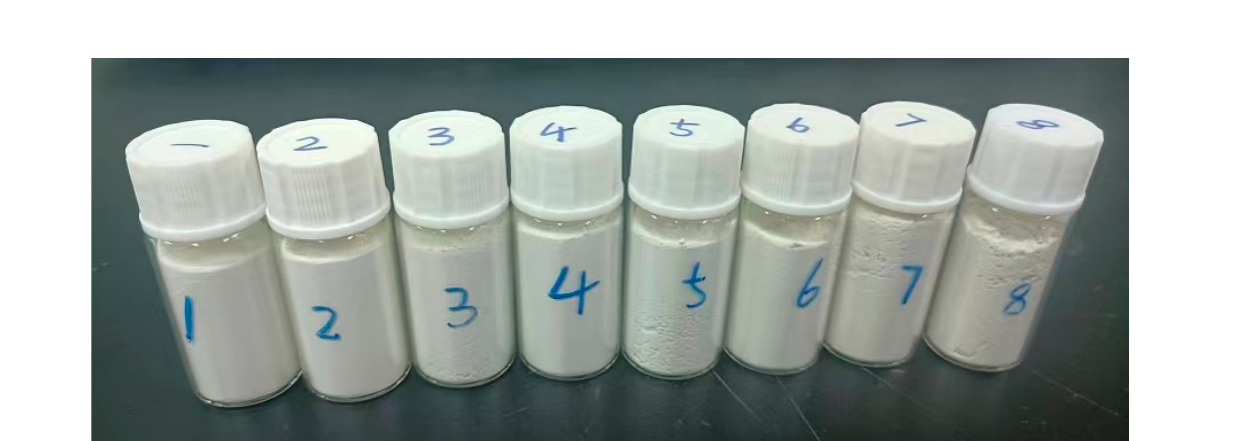
Figure 2. Samples prepared for the NMR, XRD, and FTIR tests (the samples cured at RH 5% to 98% were numbered in the sequence from 1 to 8).